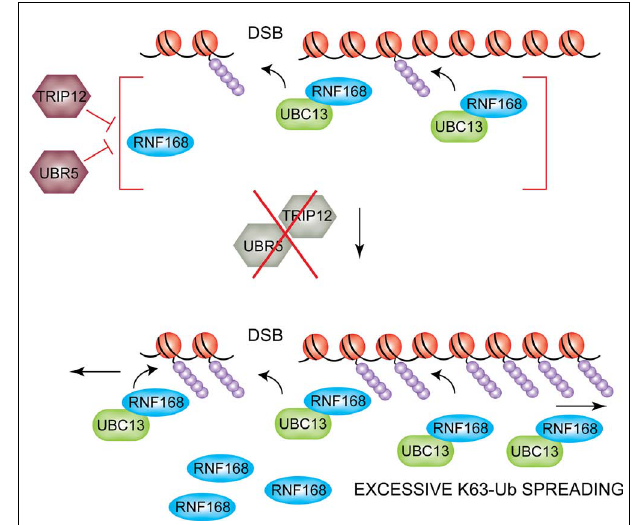
FIGURE 4 |TRIP12 and UBR5-mediated suppression of DSB-induced chromatin ubiquitylation. The HECT E3 ligasesTRIP12 and UBR5 control the nuclear pool of RNF168 (top). IfTRIP12 and UBR5 are depleted, hyper-accumulation of RNF168 triggers excessive spreading of ubiquitylated H2A/H2AX far away from the initial site of DNA lesion